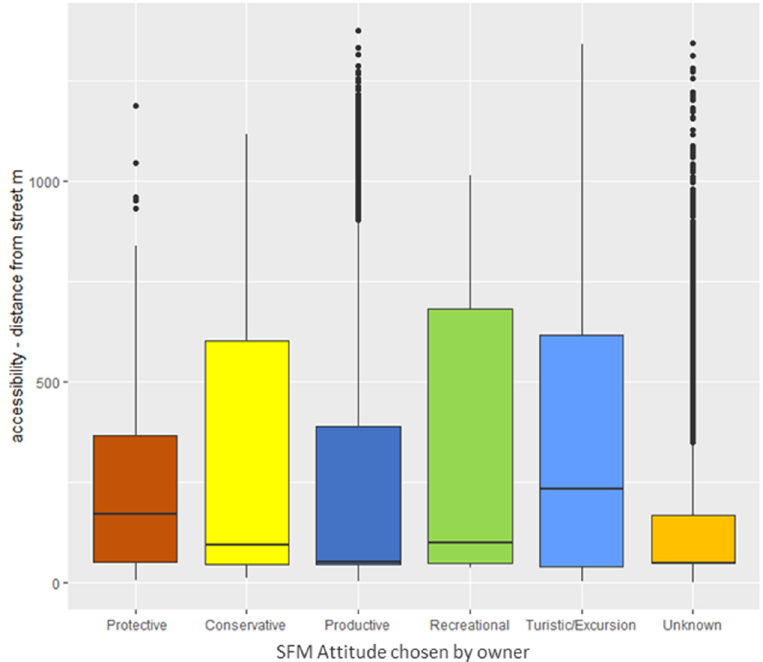
Figure 7. Distribution of accessibility by first SFM attitude for parcels in Forest Sharing ® platform.